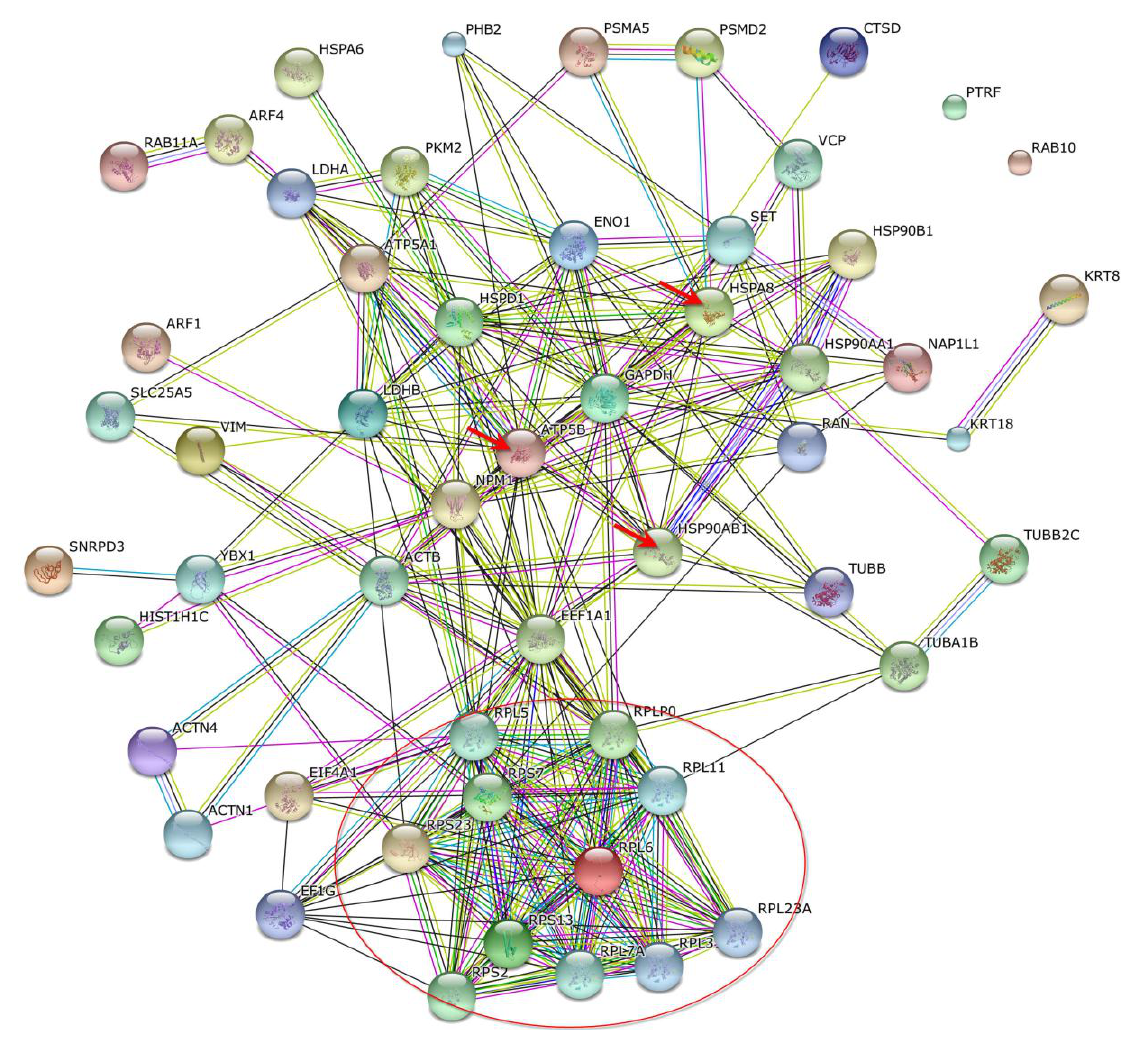
Figure 6. Schematic of the relationship between phthalic acid-binding proteins in MDA-MB-231 cells. High fold ratios were observed in triplicate experiments; the red circle includes numerous ribosomal proteins and the three red arrows indicate heat shock cognate 71-kDa protein, heat shock protein HSP 90-beta, and ATP synthase subunit